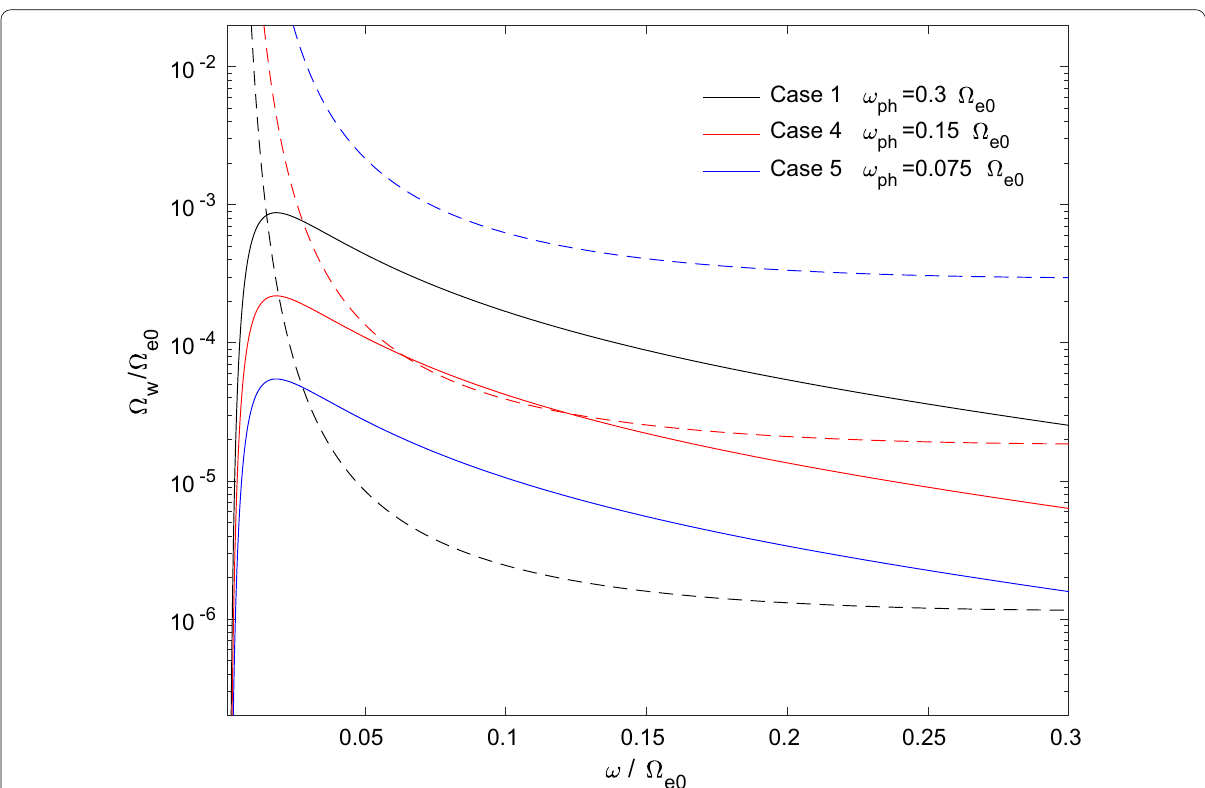
Fig. 8 Theoretical optimum amplitudes (solid lines) and threshold amplitudes (dashed lines) for different hot electron densities with parameters Q = 0.1 , τ = 0.5 , (cid:31) pe = 15 (cid:31) e 0 , a = 1.87 × 10 − 7 (� e 0 / c ) 2 , U t � = 0.26 c and U t ⊥ = 0.3